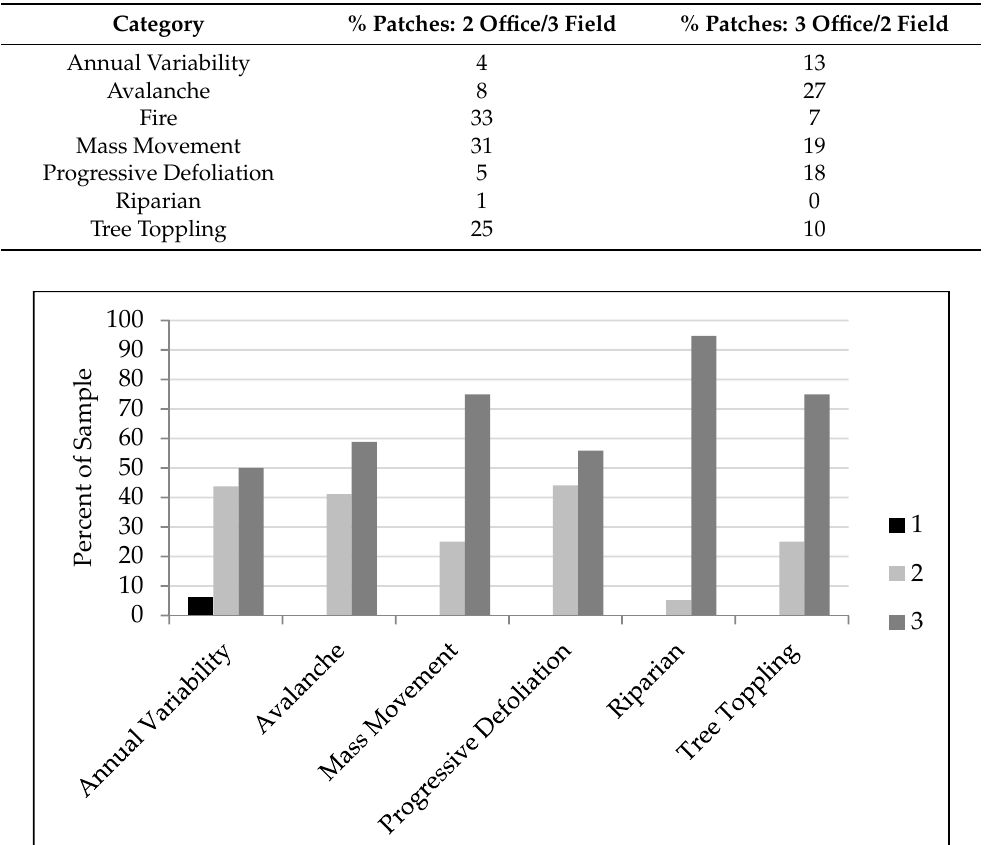
Figure 6. Distribution of confidence values among change categories for labels assigned in the field for randomly selected patches.